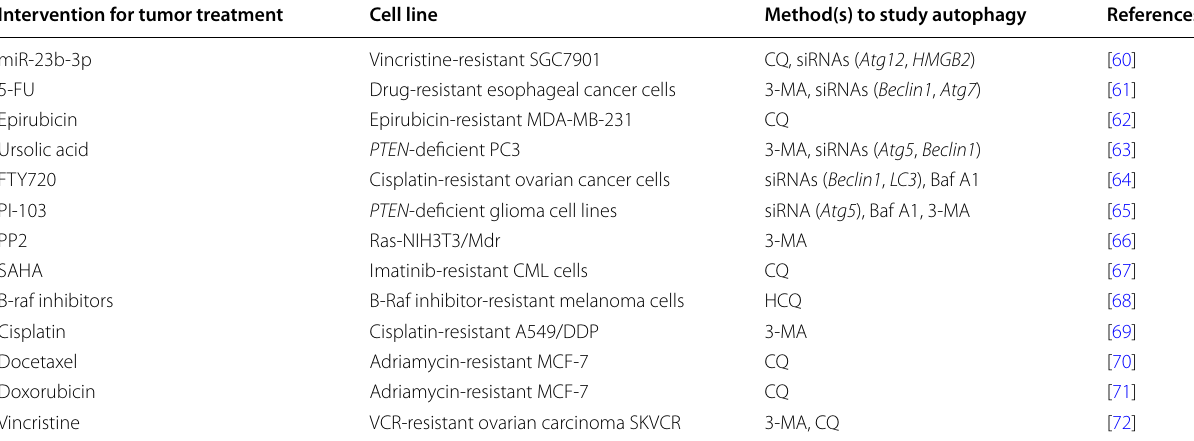
5-FU, 5-fluorouracil; FTY720, 2-amino-2-[2-(4-octylphenyl)]-1,3-propanediol hydrochloride; PP2, 4-amino-5-(4-chloro-phenyl)-7-( t -butyl)pyrazolo[3,4- d ]pyrimidine; SAHA, suberoylanilide hydroxamic acid; PTEN , phosphatase and tensin homologue; CML, chronic myelogenous leukemia; VCR, vincristine resistance; CQ, chloroquine; siRNA, small interfering RNA; Atg , autophagy-related gene; HMGB2 , high-mobility group box 2; 3-MA, 3-methyladenine; Baf A1, bafilomycin A1; LC3, protein 1 light chain 3; HCQ, hydroxychloroquine